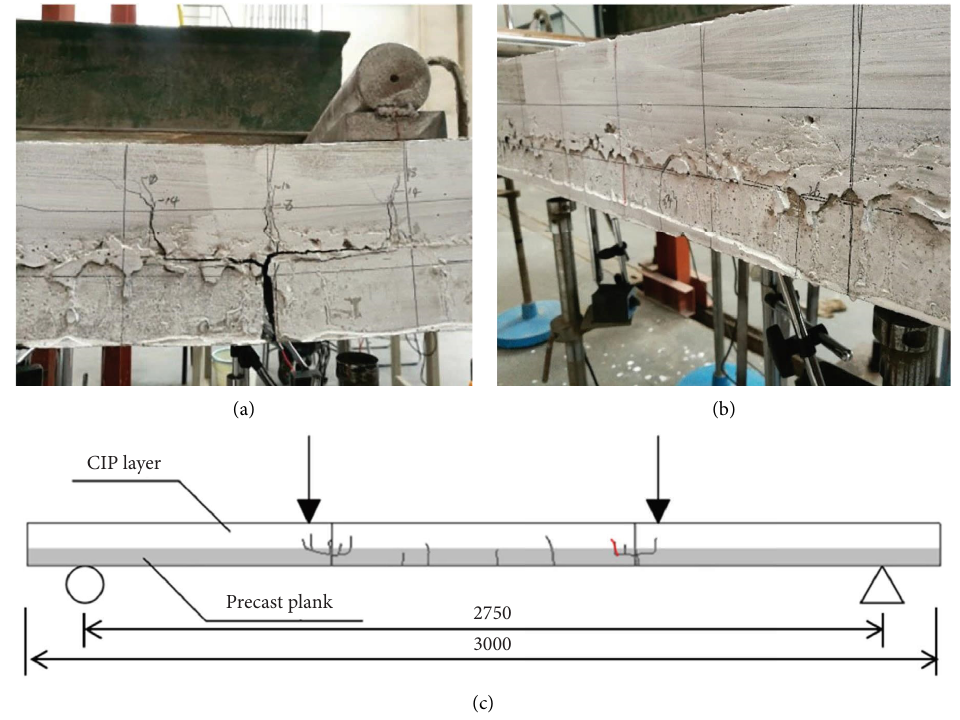
Figure 8: Failure phenomenon of LGSA2. (a) Cracking at one joint. (b) Cracking at midspan. (c) Crack